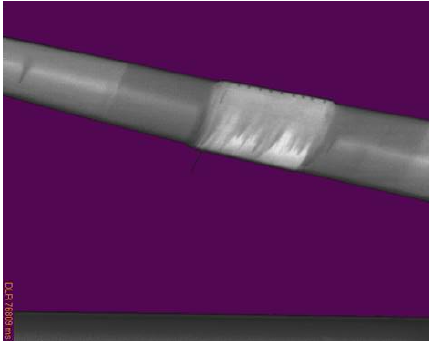
Figure 10. Thermographic picture by DLR. Leading edge (LE) bot- tom. Light areas are assumed to be in a non-turbulent (laminar) state. Used by permission of DLR.